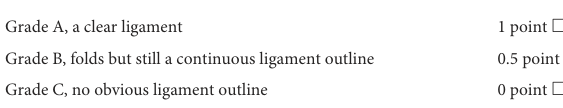
TABLE 2 The MRI graft signal integrity